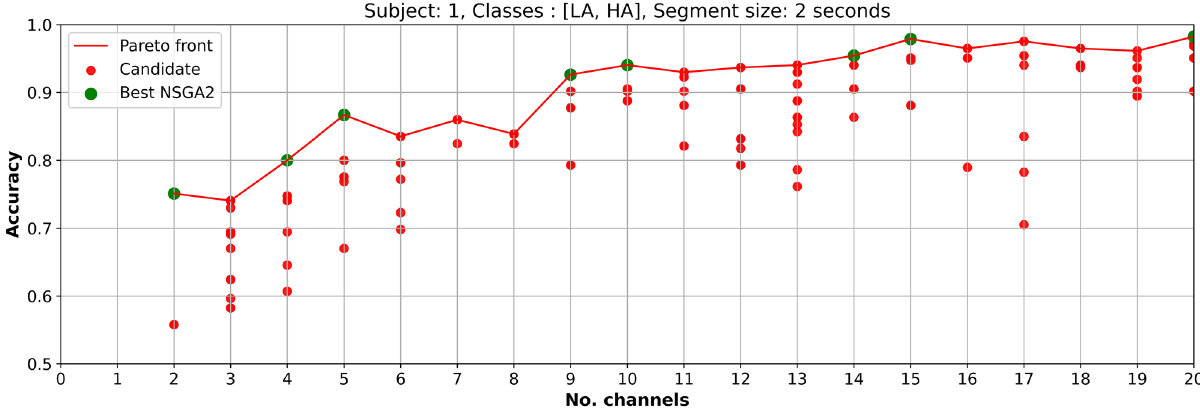
Figure 6. Optimized EEG channel selection results for low and high arousal classification using EEGNet and data from subject 1.